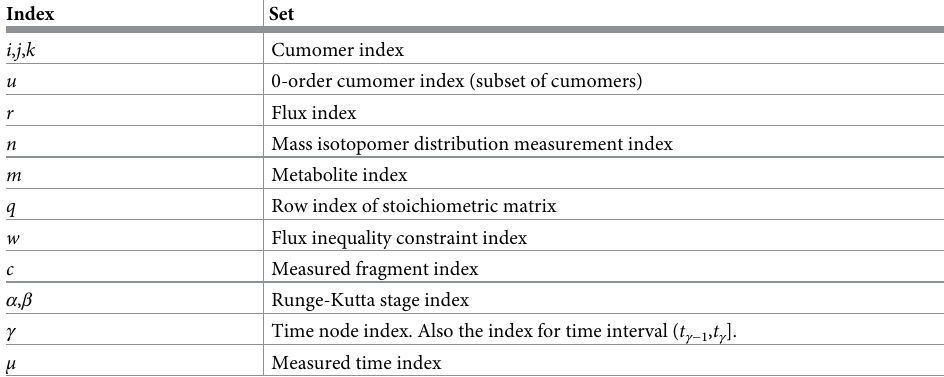
Table 1. The indexed sets used in developing the NLP of the inst-MFA problem. The Greek letters are indices used in discretizing the ODE